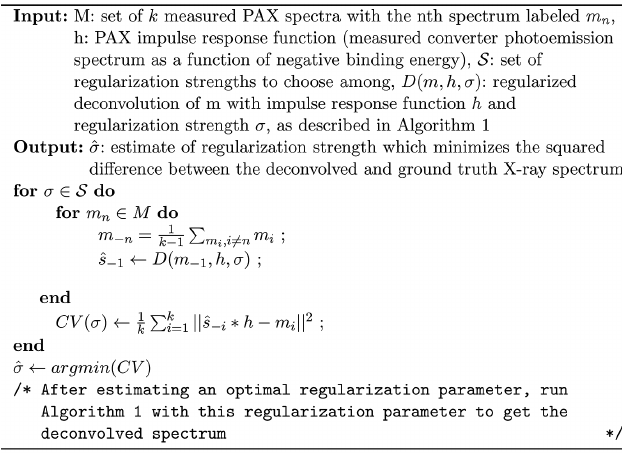
Figure 7 Algorithm 2: estimate optimal regularization strength for regularized